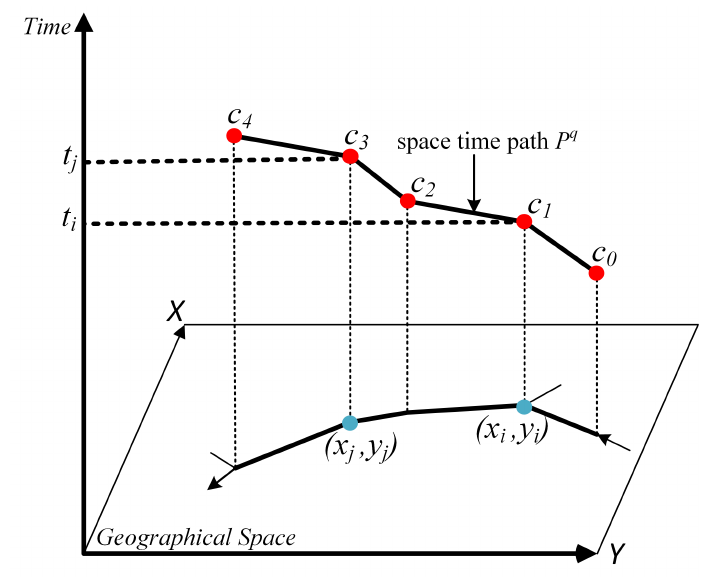
Figure 2. Spacetime route in ( x , y , t ) limited by the